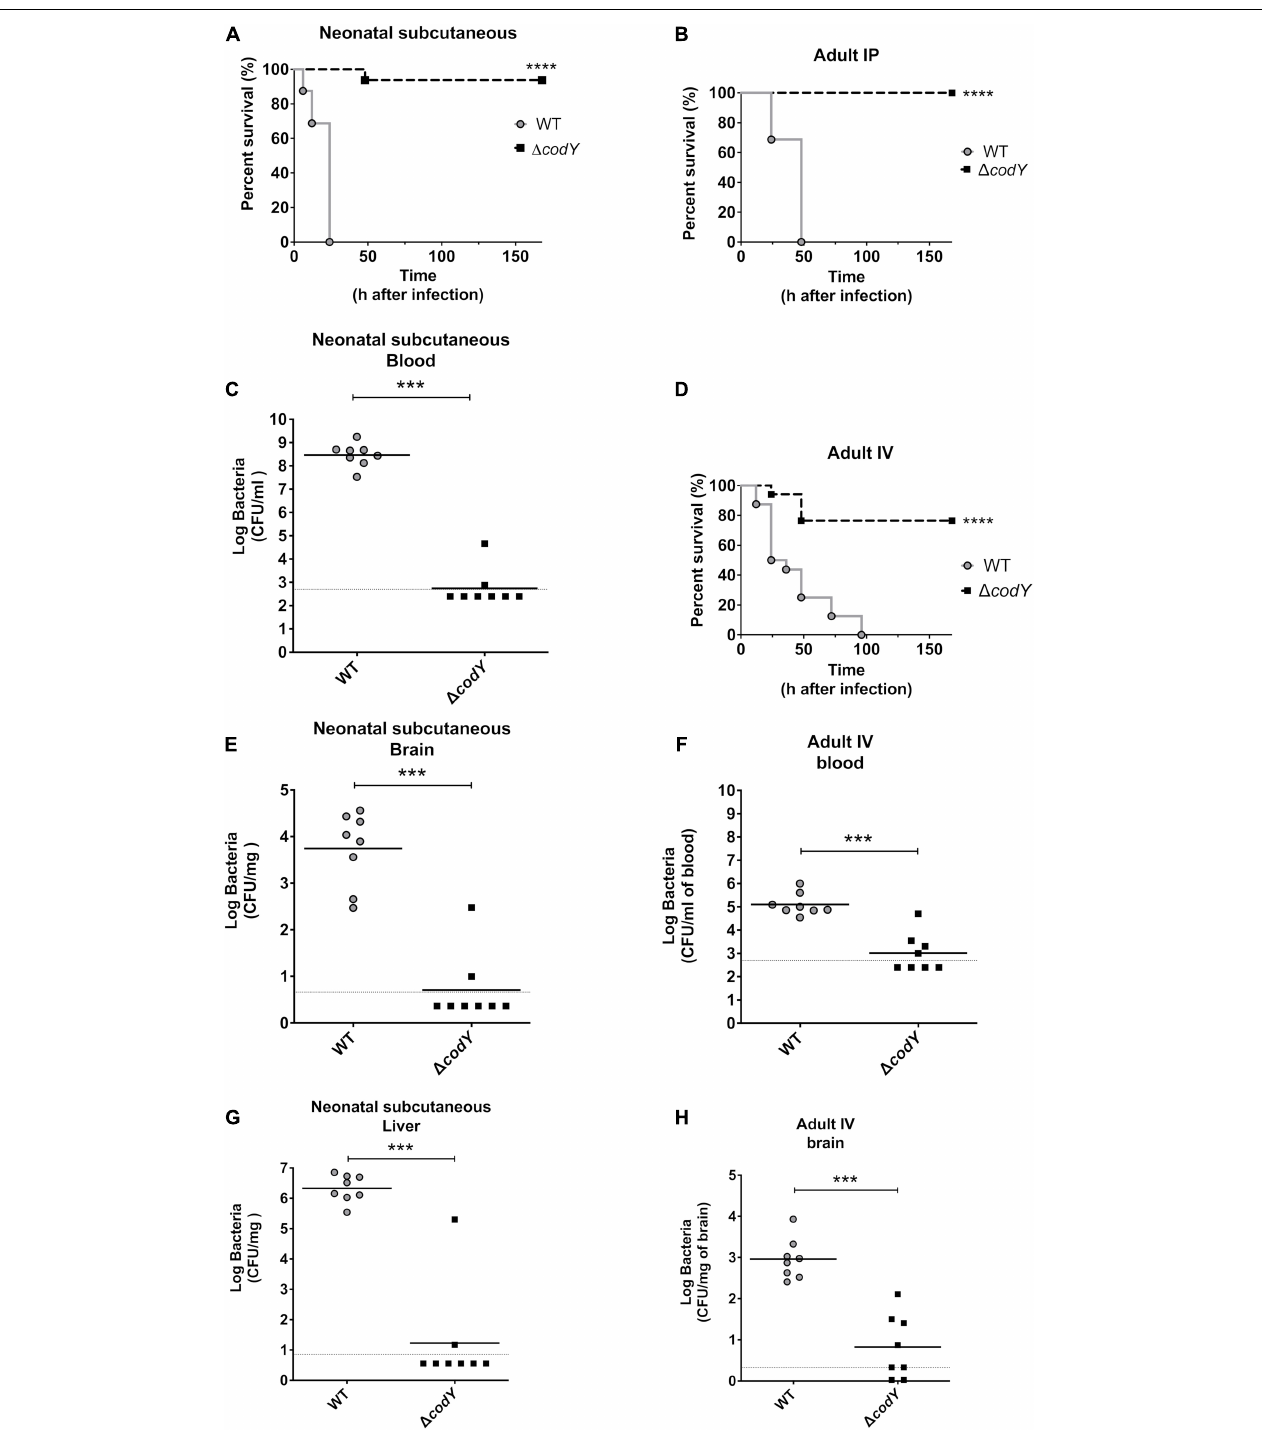
FIGURE 2 | CodY is necessary during neonatal and adult infections. (A) Lethality of newborn mice (8 per group) infected subcutaneously with 8 × 10 4 of the WT strain or the (cid:49) codY mutant. (C,E,G) Bacterial burden in the indicated organs of newborn mice infected in the same experimental condition as in panel (A) ; horizontal bars indicate mean log CFU values. (B) Lethality of adult mice (8 per group) infected intraperitoneally (IP) with 5 × 10 8 of the WT strain or (cid:49) codY mutant. (D) Lethality of adult mice (8 per group) infected intravenously (IV) with 1 × 10 9 CFU. (F,H) Bacterial burden in the indicated organs of adult mice infected in the same experimental condition as in panel (D) ; horizontal bars indicate mean log CFU values. *** p < 0.001; **** p < 0.0001 by the Kaplan Meier (panels A,B,D ) or Mann Whitney test (panels C, E–H ).